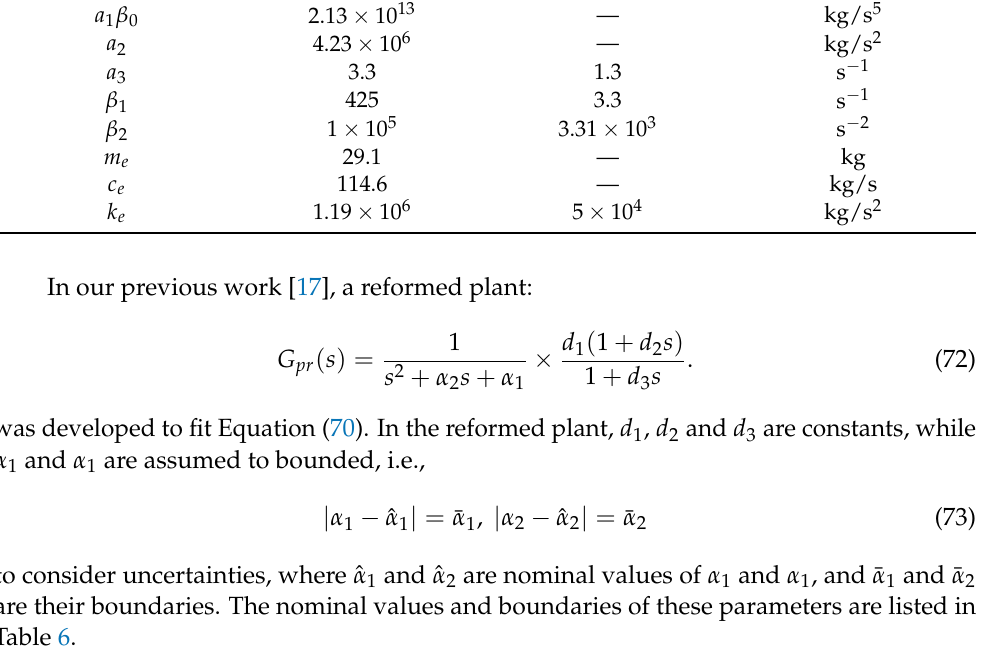
Table 5. Nominal values and standard deviations of the physical plant’s parameters. Parameter